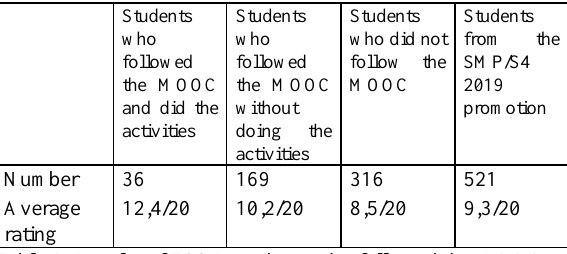
Table 2: Results of FSSM students who followed the MOOC compared to students who did not follow